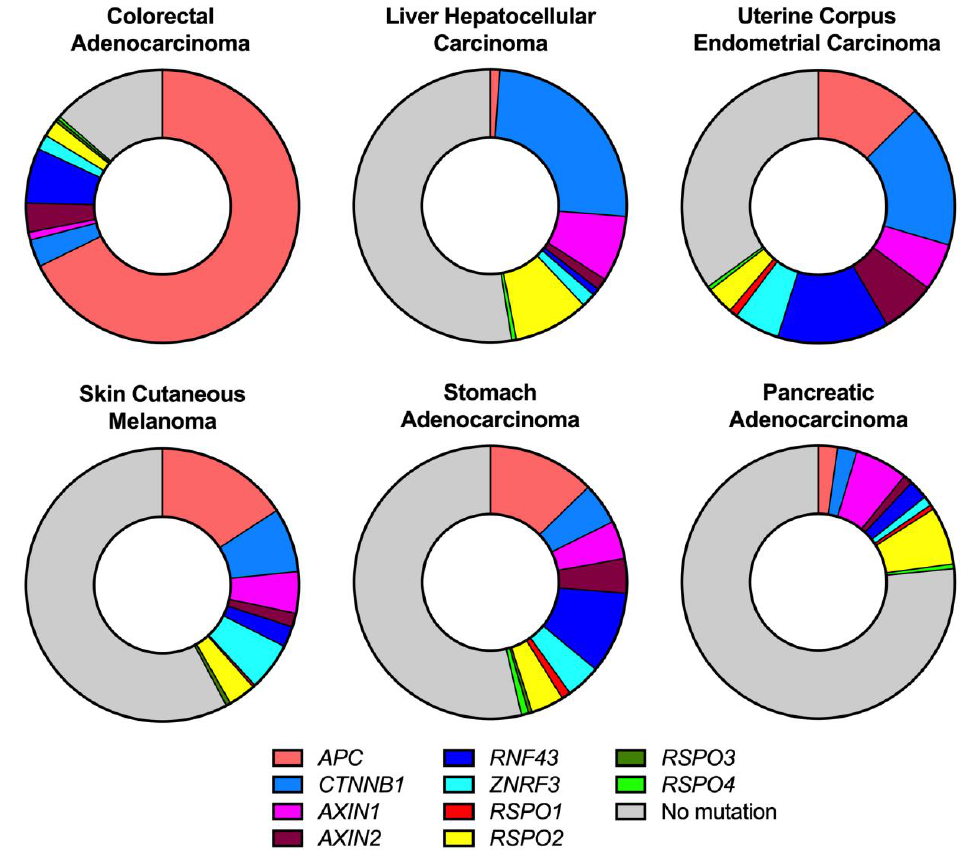
Figure 2. An overview of the frequency of certain WNT pathway mutations found in colon, liver, endometrial, gastric, pancreatic, and skin cancer. Data from The Cancer Genome Atlas’s PanCancer Atlas on cBioportal [30,31], as of 15 February 2023. No mutation indicates patients in the queried datasets that did not have a mutation in any of the genes shown above.